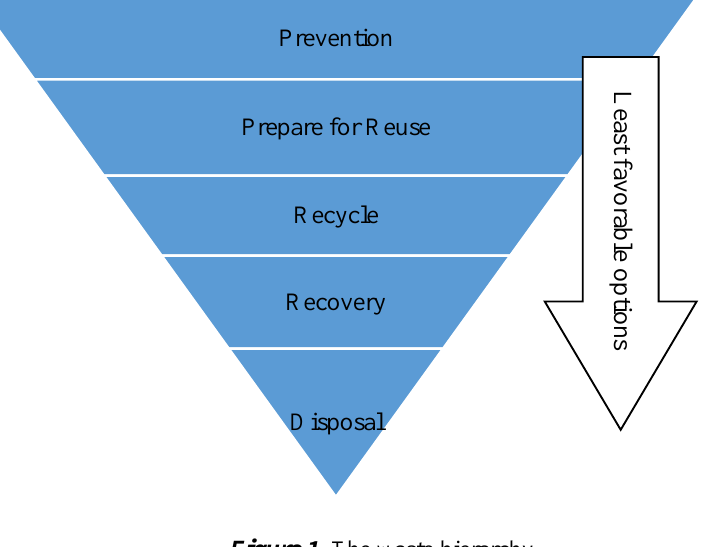
Figure 1. The waste hierarchy.